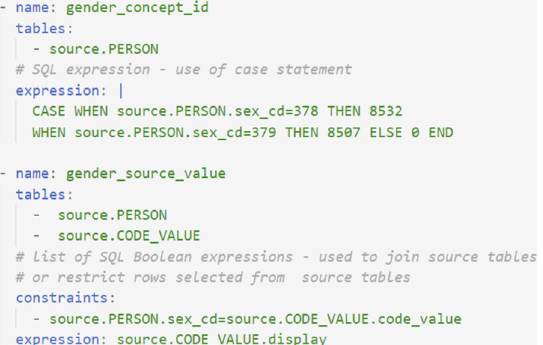
Fig 4. Use of PostgreSQL syntax to define mapping logic. An example of mapping logic to populate the gender_concept_id and the gender_source_value columns in the OMOP PERSON table. The transformation to populate gender_concept_id uses a CASE statement (if-then-else). The transformation to populate gender_source_value uses the data from two source tables, with the constraint indicating how these two source tables are